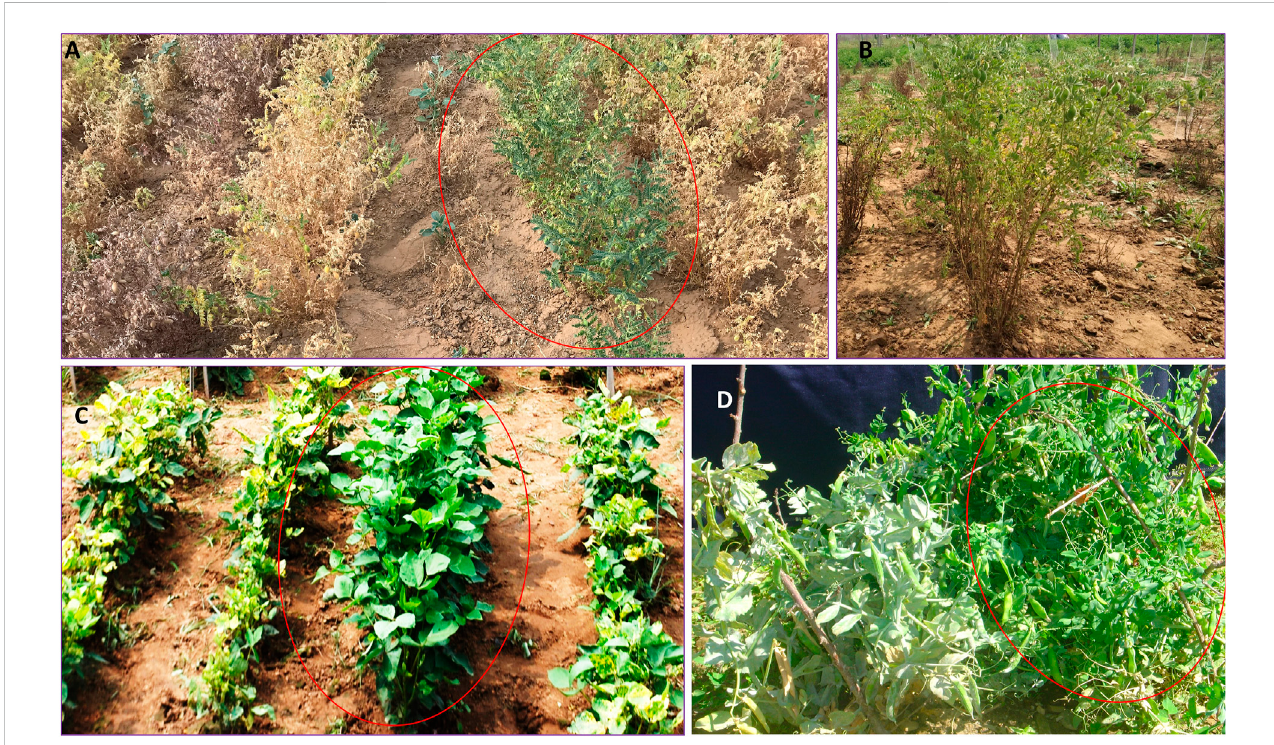
FIGURE 4 Several promising newly identi fi ed resistance donors: IC486215 (A) for resistance against dry root rot in chickpea; IC275447 (B) for resistance against ascochyta blight in chickpea; IC118998 (C) for yellow mosaic disease (YMD) resistance in green gram; and IC278261 (D) for powdery mildew resistance in fi eld